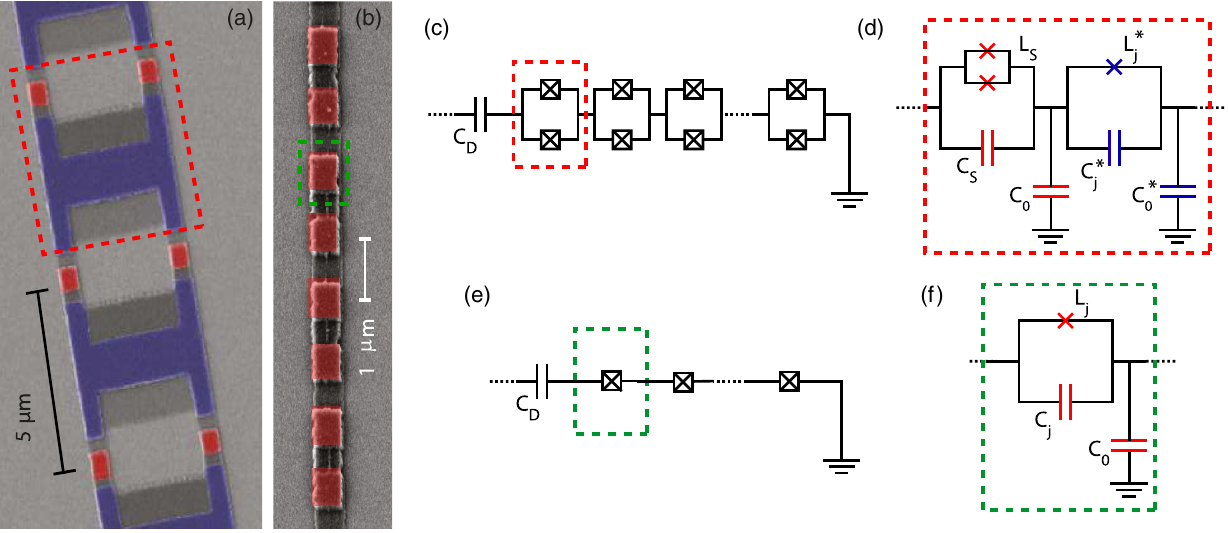
FIG. 8. Comparison between a SQUID and a junction array resonator. (a) False-colored SEM micrograph of a section of a SQUID array. The dashed red line encloses the unit cell of the SQUID array. (b) False-colored SEM micrograph of a section of a Josephson- junction array. The dashed green line encloses the unit cell of the array, with a single 0 . 5 × 0 . 9 μ m 2 Josephson junction. (c) Schematic C C C circuit for a λ = 4 SQUID array resonator. C represents the capacitive coupling between the resonator array and the D ¼ c þ g RPG þ microwave feedline, the DQD device, and the rest of the DQD gates. The other end of the array is grounded. (d) Circuit schematic of the unit cell of the SQUID array. L and L ⋆ represent the inductance of each SQUID junction (red) and of the extra Josephson junction S J (blue) connected in series, while C (red) and C ⋆ (blue) represent their junction capacitance. C 0 and C ⋆ 0 are their respective capacitances S J to the ground. (e) Schematic circuit for a λ = 4 JJ array. (f) Circuit schematic of the JJ array ’ s unit cell. L inductance, while C and C 0 are the junction capacitance and the stray capacitance to J